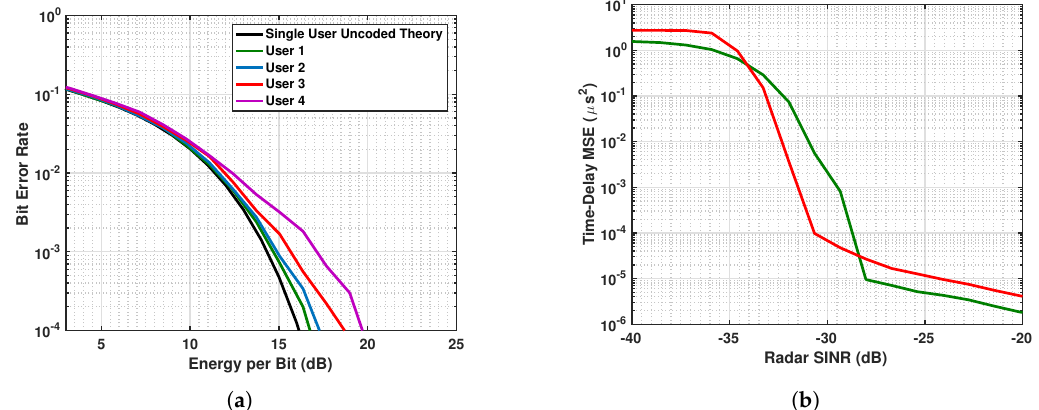
Figure 9. ( a ) BER and ( b ) time-delay estimation mean-squared error (MSE) performance ( red ) for coexisting systems using communications parameters Ψ c in Equation (27) and radar parameters Ψ r in Equation (32). In ( b ), also shown ( green ) is the MSE performance obtained using a radar waveform that minimizes the